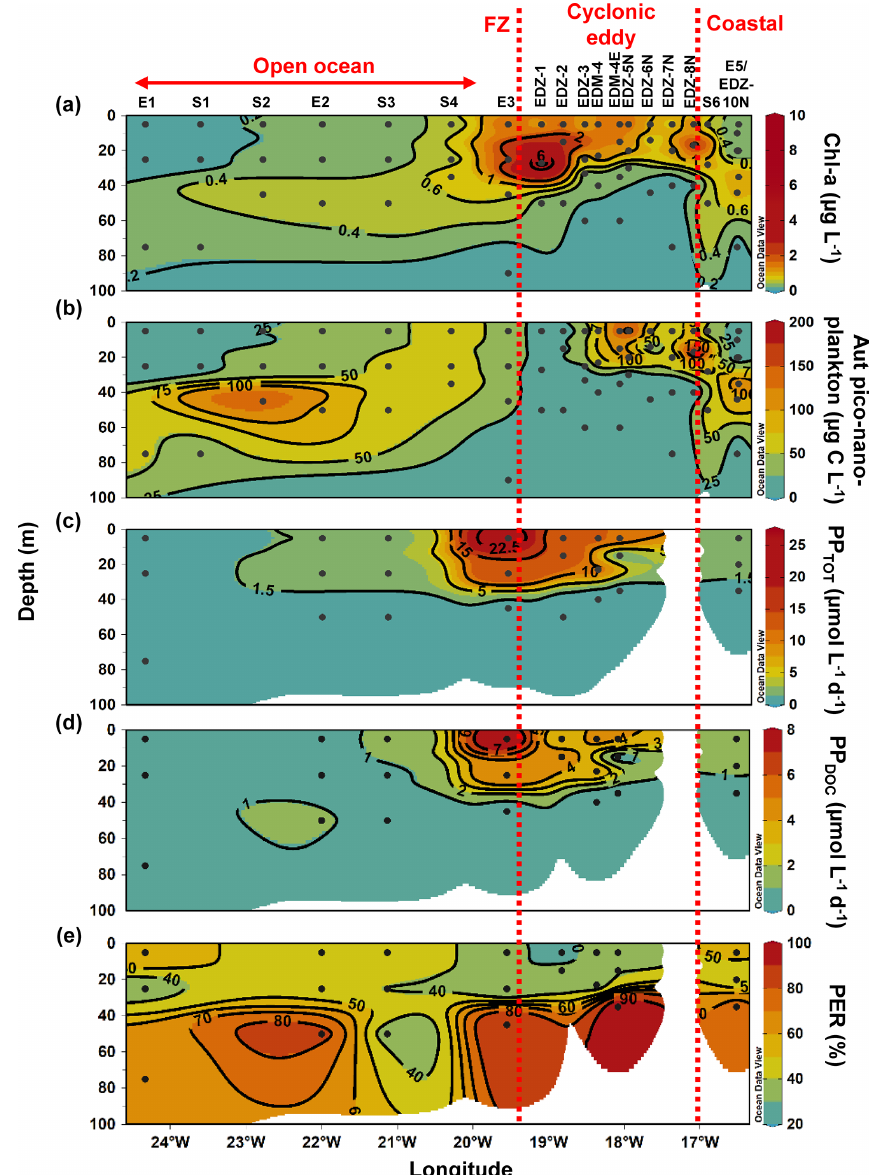
Figure 4. Depth distribution of phytoplankton biomass and activity from the surface to 100m. Chlorophyll a (Chl a ; a ), autotrophic pico- and nanoplankton biomass (Aut pico-nanoplankton; b ), total primary production (PP TOT ; c ), dissolved primary production (PP DOC ; d ), and percentage of extracellular release (PER; e ). Dashed red lines show the western and eastern boundaries of the cyclonic eddy periphery. FZ refers to frontal